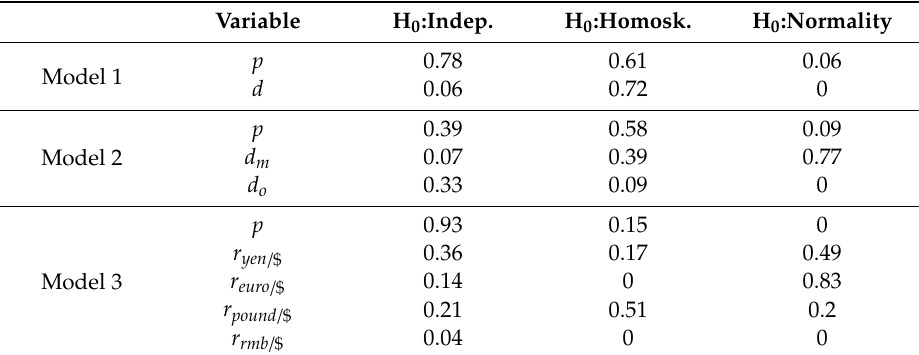
Table 5. p -Values for statistical properties of residuals 1999:1–2018:12.